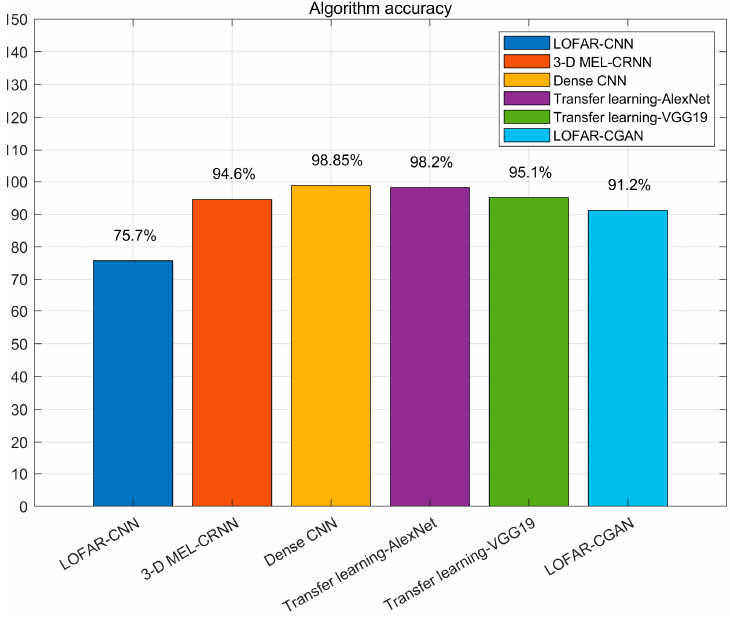
Figure 10. Accuracy of partial method recognition. Table 1. Preprocessing methods.